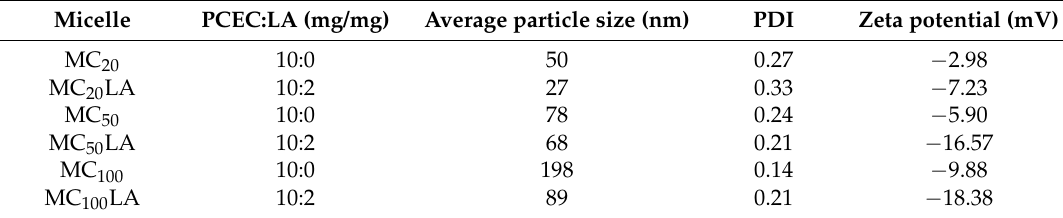
Table 3. The particle sizes and distribution of the micelles. PDI stands for polydispersity index. Micelle PCEC:LA (mg/mg) Average particle size (nm) PDI Zeta potential (mV) MC 20 10:0 50